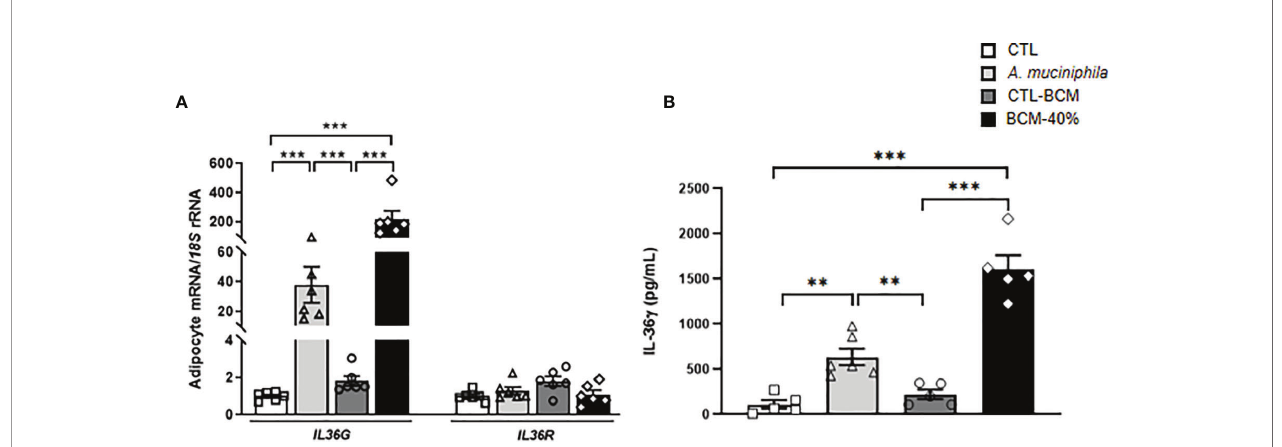
FIGURE 3 | (A) Gene expression levels of IL36G and IL36R as well as (B) release of IL-36 g in visceral adipocytes after the incubation with Akkermansia muciniphila or bacterial conditioned medium (BCM). Bar graphs represent the mean ± SEM. Differences between groups were analyzed by one-way ANOVA followed by Tukey ’ s